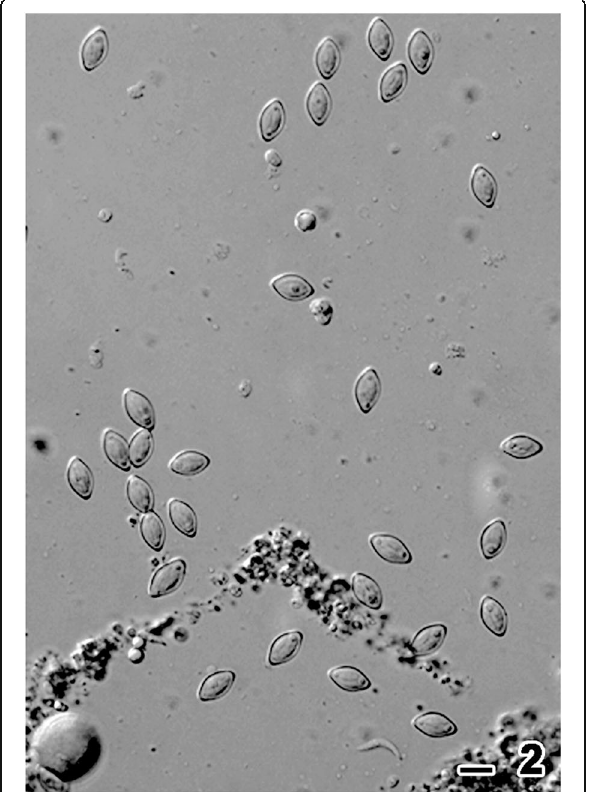
Fig. 2 Fresh oocysts of Mattesia dispora from Ephestia kuehniella . Hemolymph with navicular free oocysts (arrows) including sporozoites and a free sporozoite (arrowhead). Bars, 10 μ